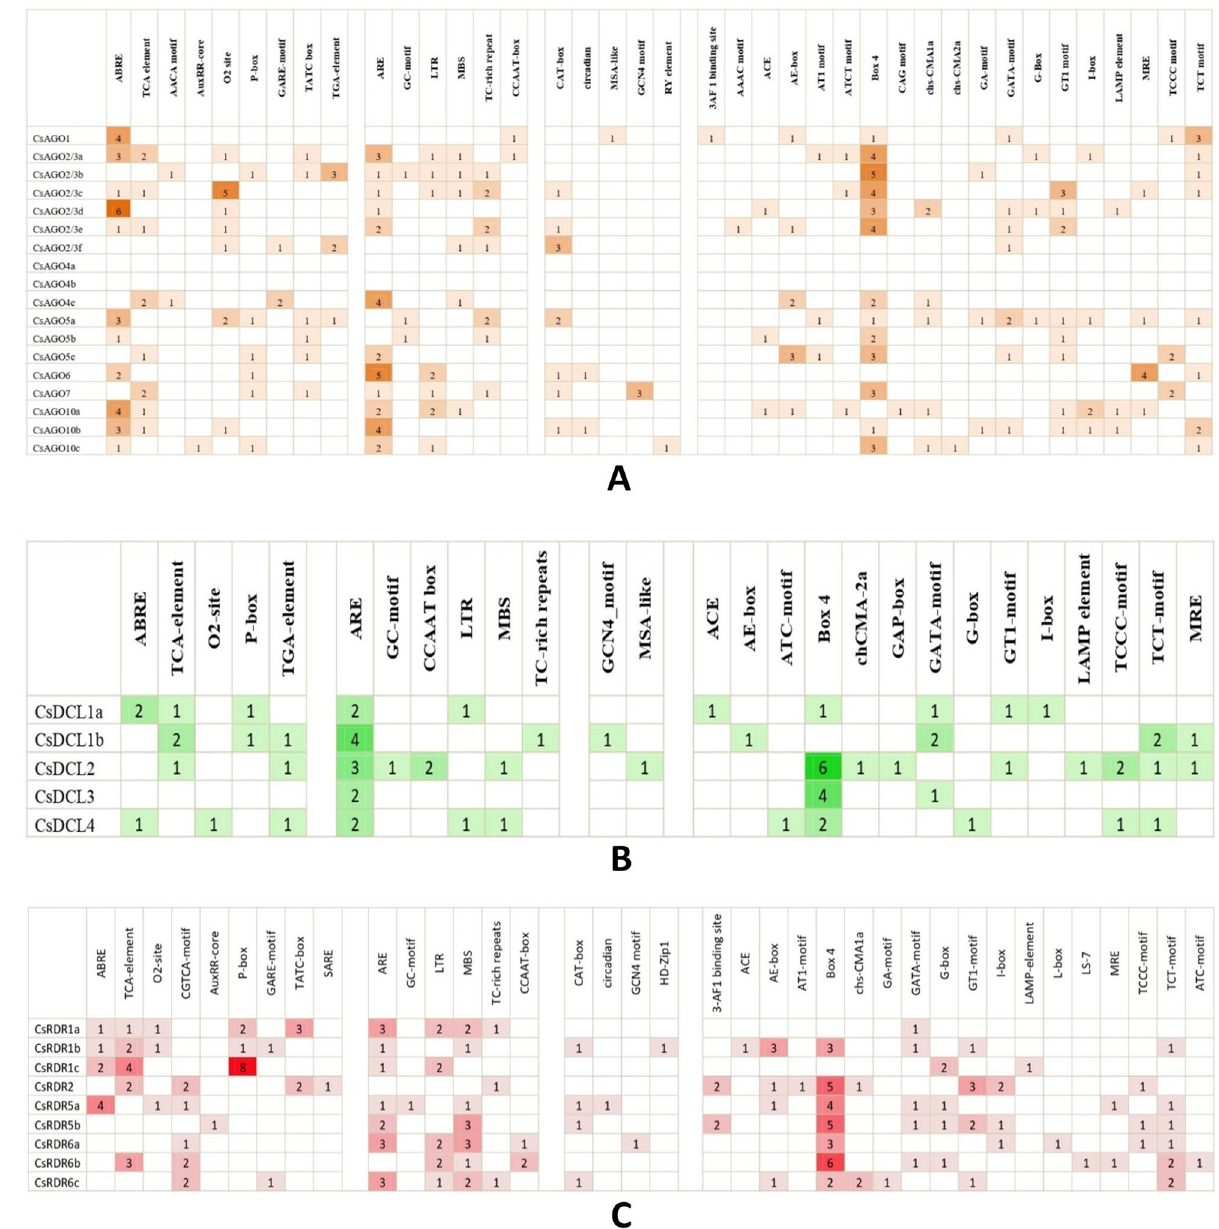
Figure 6. Number of each cis-acting element in the promoter region (2 kb upstream of translation start site) of respective genes belonging to ( A ) CsAGO , ( B ) CsDCL and ( C ) CsRDR . The elements have been separated into four distinct groups (by using a blank column between two groups) based on their functional properties (categories from left to right—hormone responsive; stress and defence response; plant growth and development; light